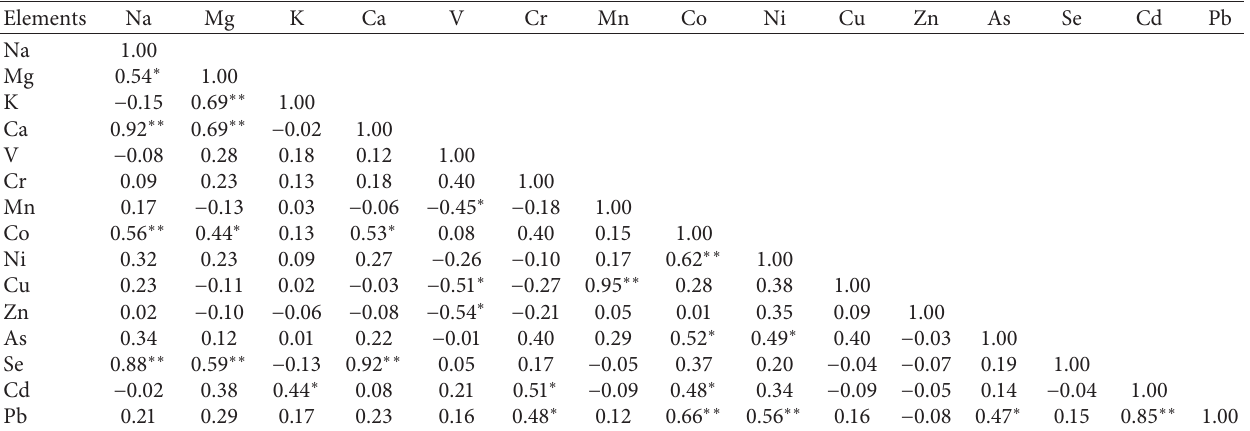
Table 4: Correlation coefficients of 15 major and trace elements of the 23 $ groundwater samples.